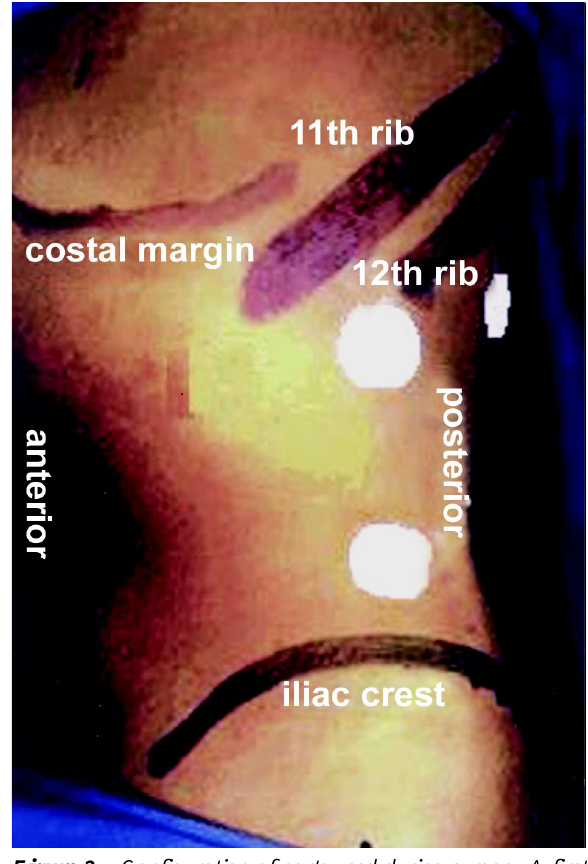
Figure 2 – Configuration of ports used during surgery. A first 12-mm port located between the extremities of the 11th and 12th ribs (where the ureteral stumps were exteriorized), a second 10- mm port located 2 cm from the iliac spine (for the 0 grade optic) and a third 5-mm port located 1.5 cm from the costovertebral angle’s